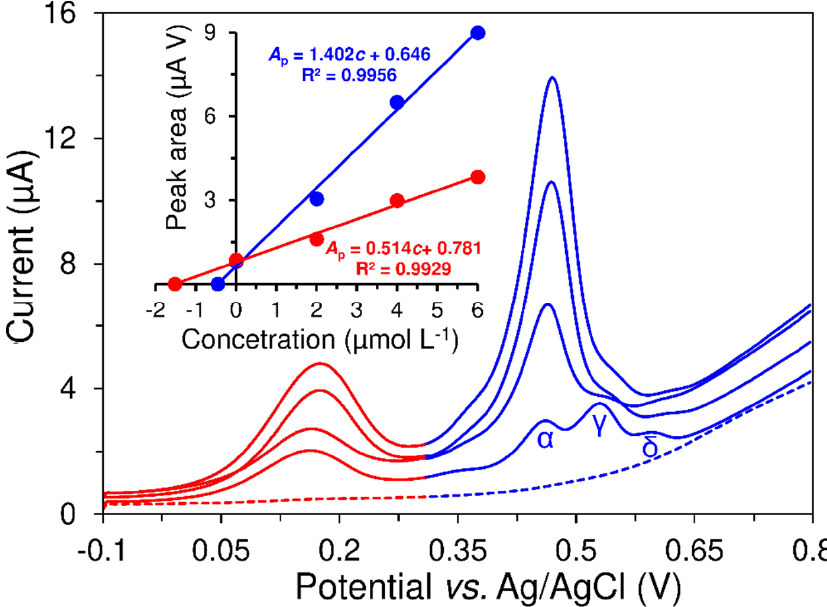
Figure 5. SWAdSV voltammograms of mixture of two different food supplements analyzed by standard addition method (inset).